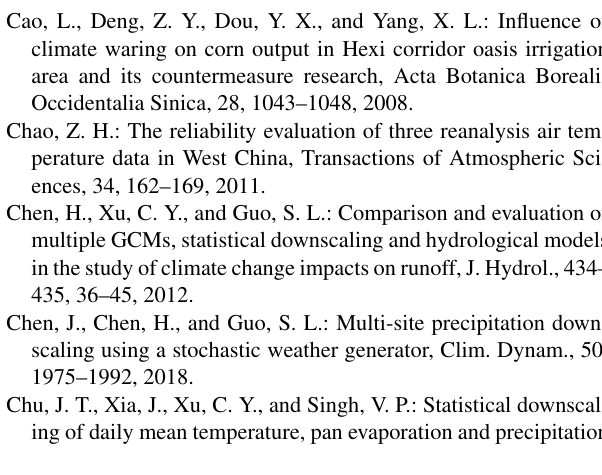
RCP8.5 > RCP4.5 > RCP2.6. The increase in the